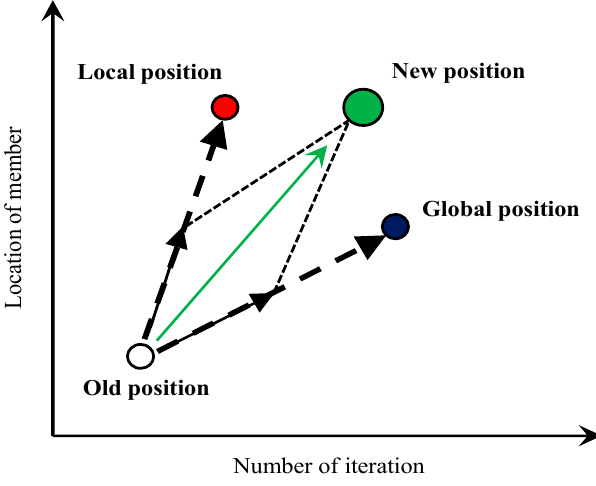
Figure 14. Movement of a member.